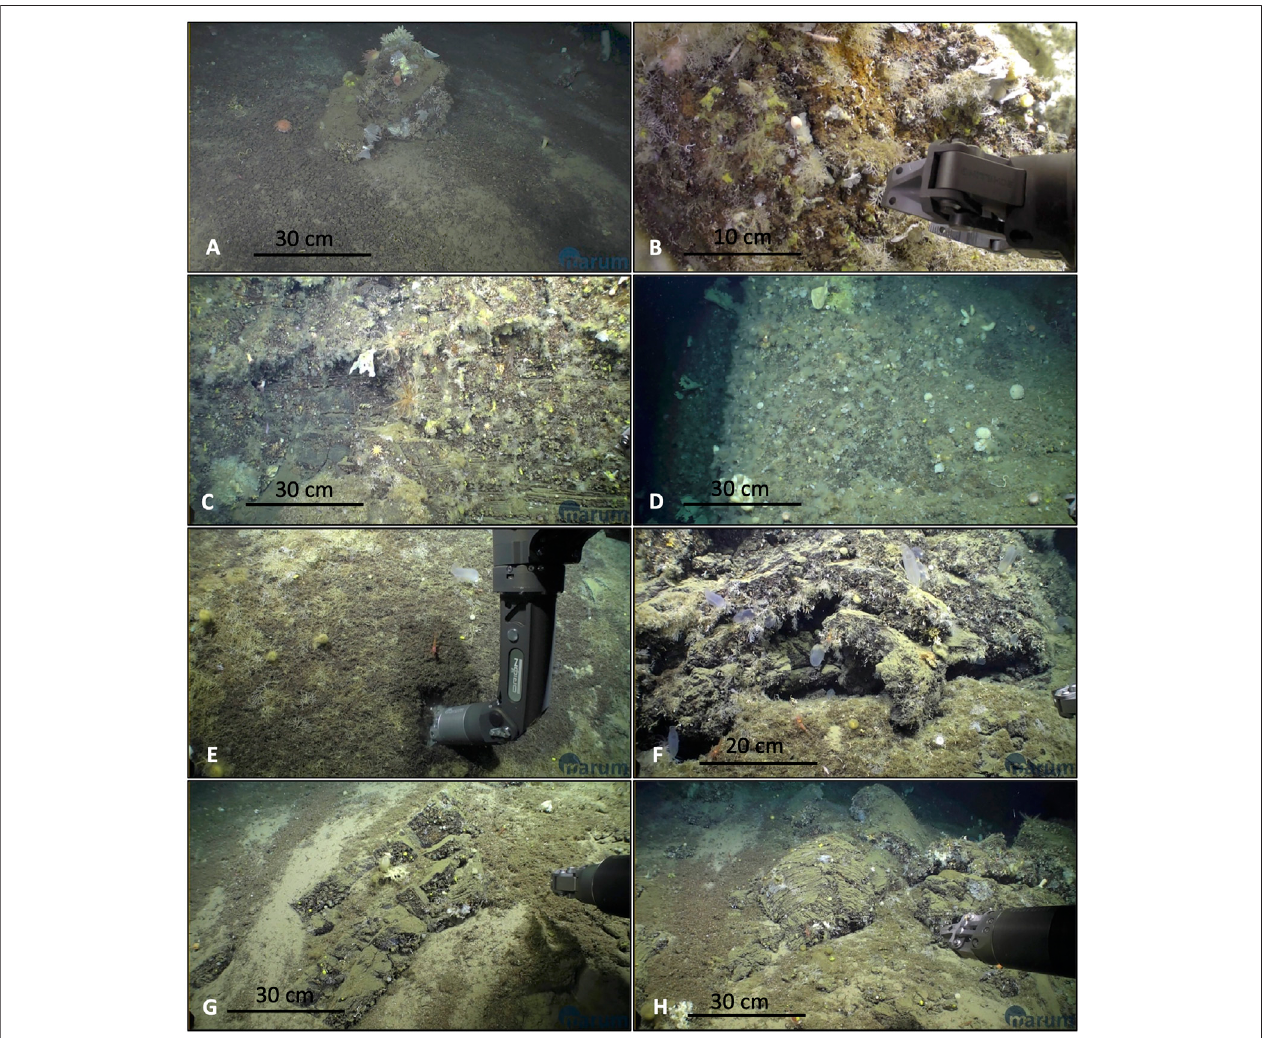
FIGURE9| ImagesofeightdifferentfaciestypestakenwiththeROVcamerasystem.See Figure2 forROVdivelocations. (A) Slopefrom010ROV,coveredby fi ne sediment, lapilli and rock fragments with biota. (B) Close up of volcaniclastic deposits during 052ROV. (C) Vertical wall of laminated pyroclastic material observed at 061ROV. (D) High wall made up of hyaloclastites at 081ROV. (E) Example of a slope covered by a thick spiculite mat during 086ROV. (F) Lobate lava from 086ROV. (G) Sheet lava outcrop from 094ROV. (H) Pillow lava with a ropy structure from 094ROV.